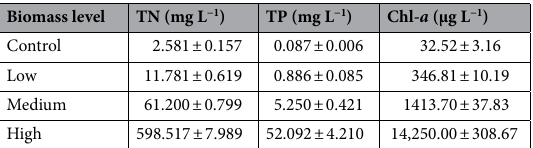
Table 6. The TN, TP and Chl-a contents of each treatment at the